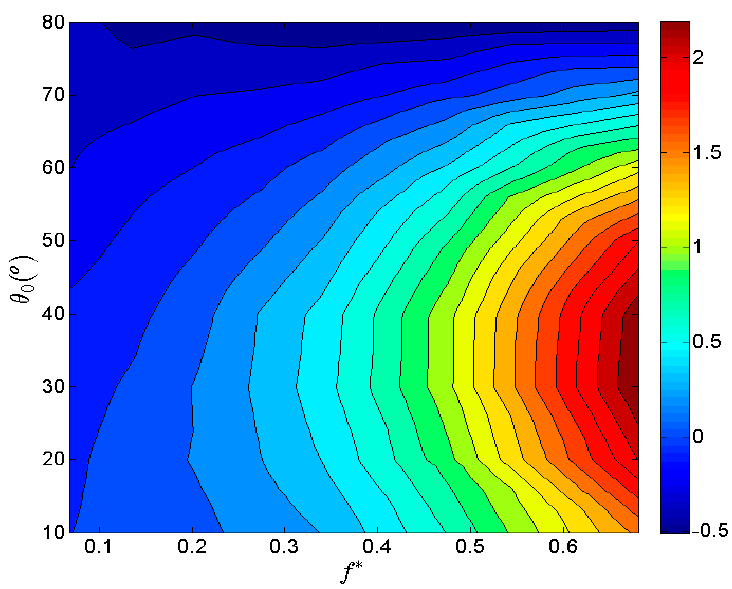
Figure 4. The mean output power coefficient contour on the parametric space of reduced frequency and pitching amplitude.